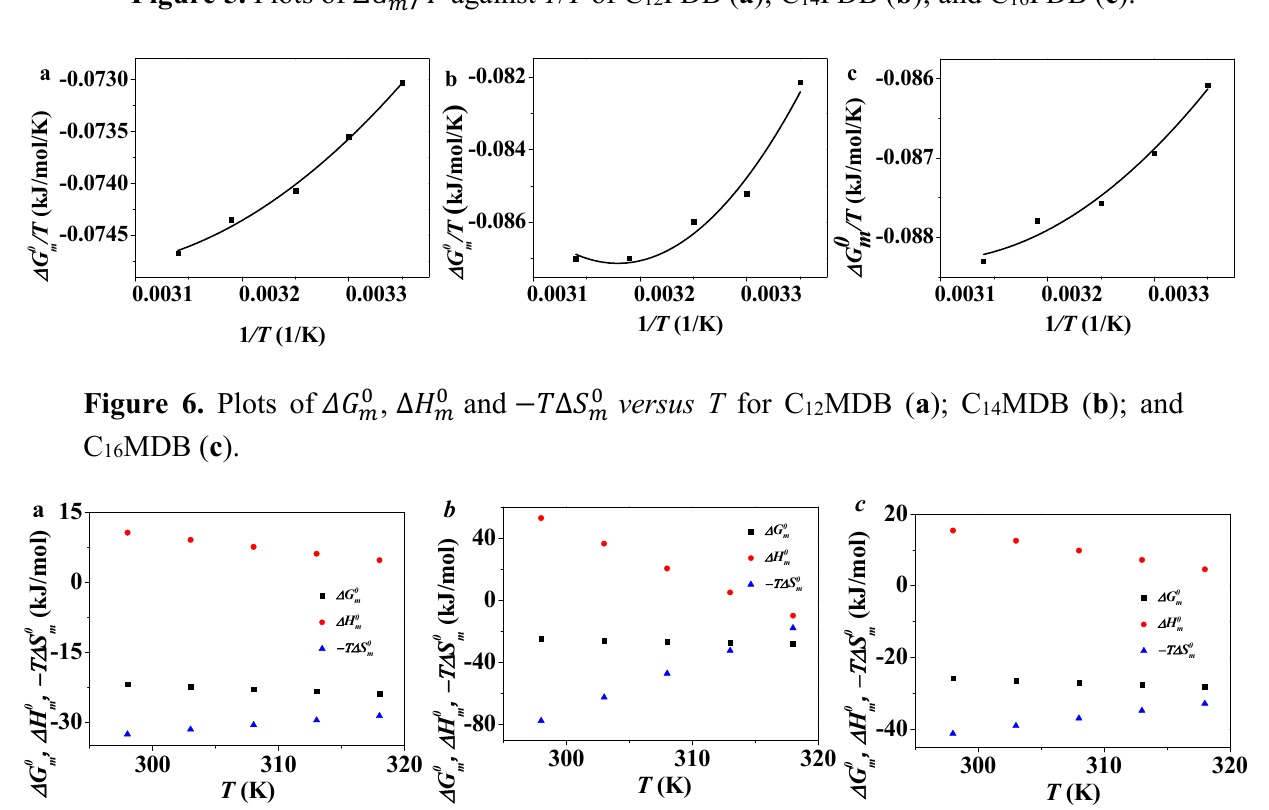
Figure 5. Plots of (cid:1986)(cid:1833) (cid:3040)(cid:2868) /(cid:1846) against 1 / T of C 12 PDB ( a ); C 14 PDB ( b ); and C 16 PDB ( c ).